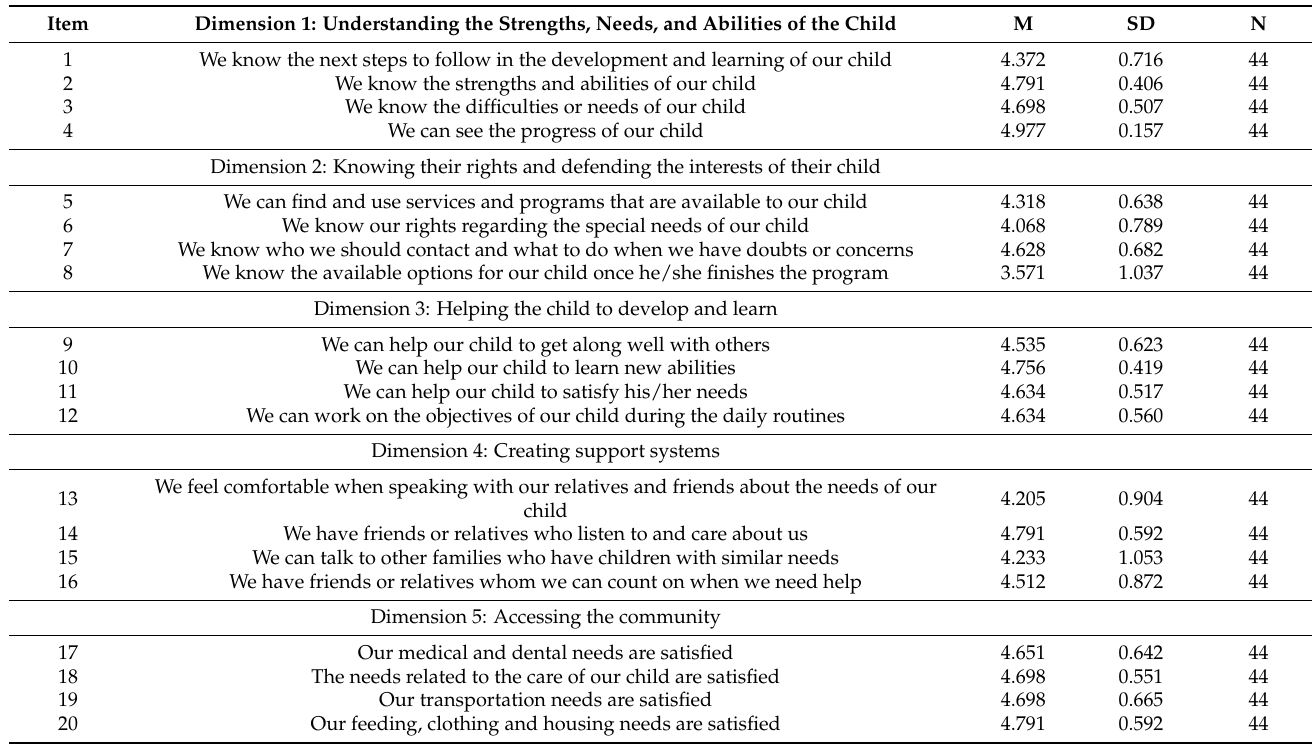
Table 3. Results of empowerment by dimensions and